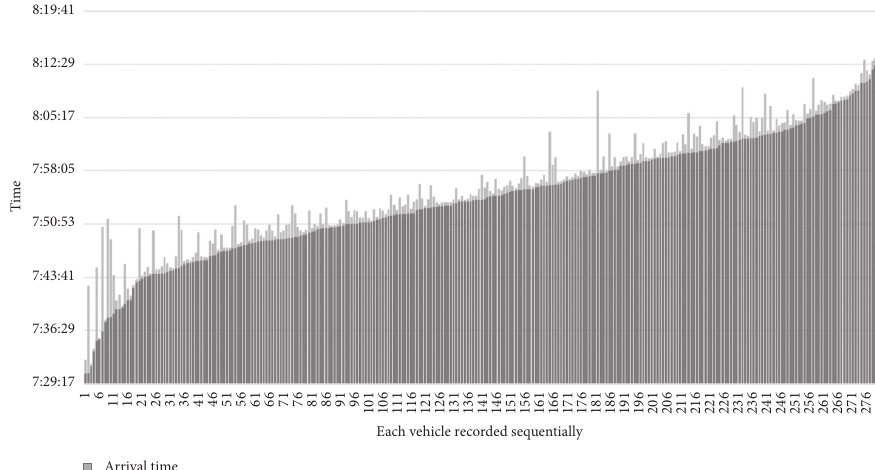
Figure 1: The number of vehicles at a certain time of the first